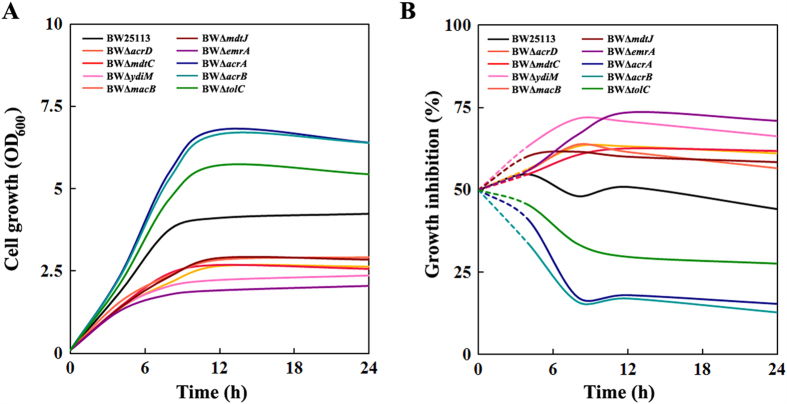
Growth phenotype of isoprenol susceptible and resistant mutants.(A) Cell growth of transporter mutants. (B) Growth inhibition of transporter mutants. Susceptible mutants BWΔacrD (orange), BWΔemrA (purple), BWΔmacB (tomato) BWΔmdtC (red), BWΔmdtJ (maroon) and BWΔydiM (pink); resistant mutants BWΔacrA (blue), BWΔacrB (cyan) and BWΔtolC (green); and wild type E. coli BW25113 (black) were grown in 2YT medium with 0.5% (v/v) of isoprenol at 30 °C. Cell growth was measured every 6 h. Growth inhibition was calculated as described in Materials and Methods. Initial growth inhibition was assumed as 50% in all strains. Results are the means of two biological replicates.